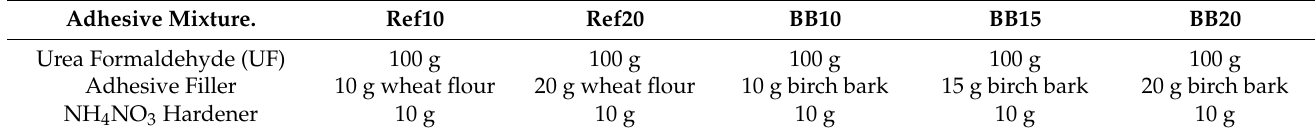
Table 3. Composition of adhesive mixtures used in this research work. Adhesive